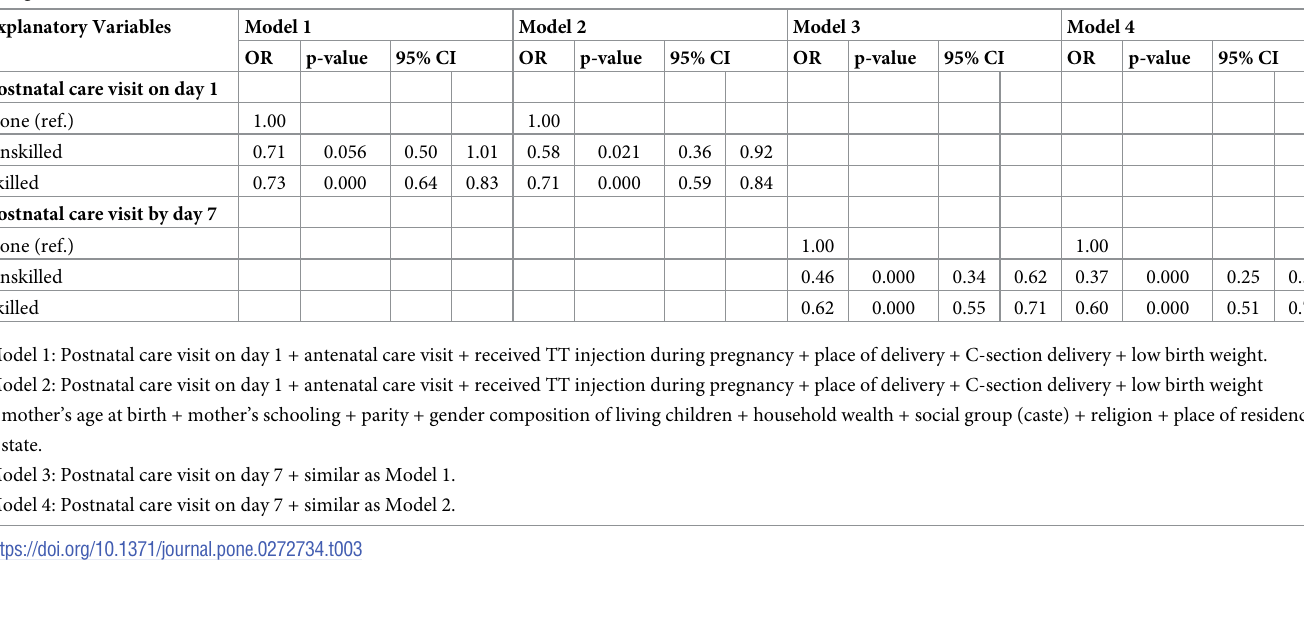
Table 3. Parameter estimates (Odds Ratio) for binary weighted logistic regression models of neonate deaths between Days 2 and 7 by PNC types and other selected background variables (N = 187702) India,